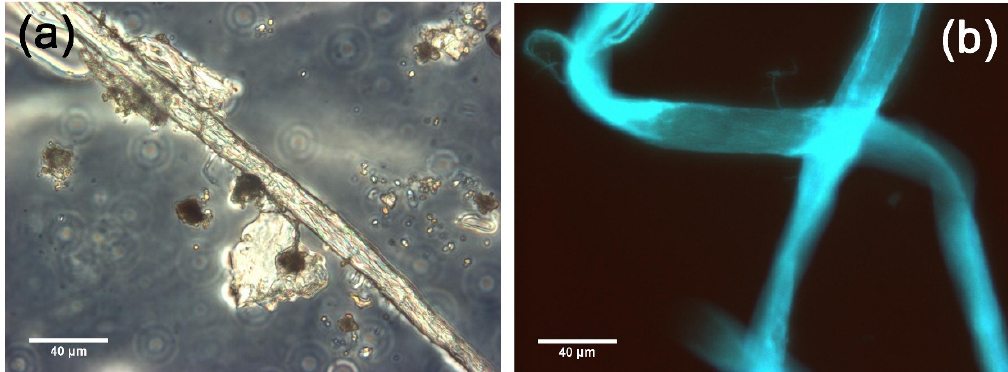
Figure 3. Bright field ( a ) and epifluorescence ( b ) microscope images of sample S9 from green patina on tile T9.